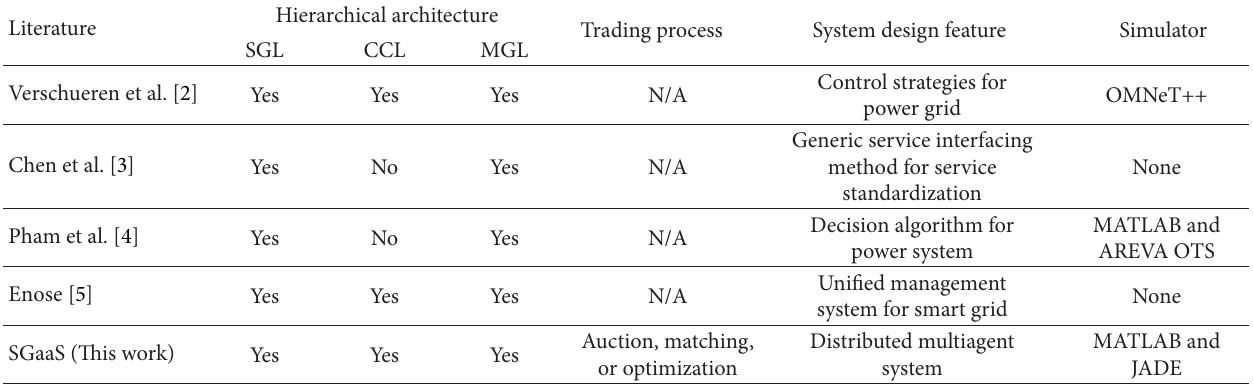
Table 1: Comparison of SOA in smart